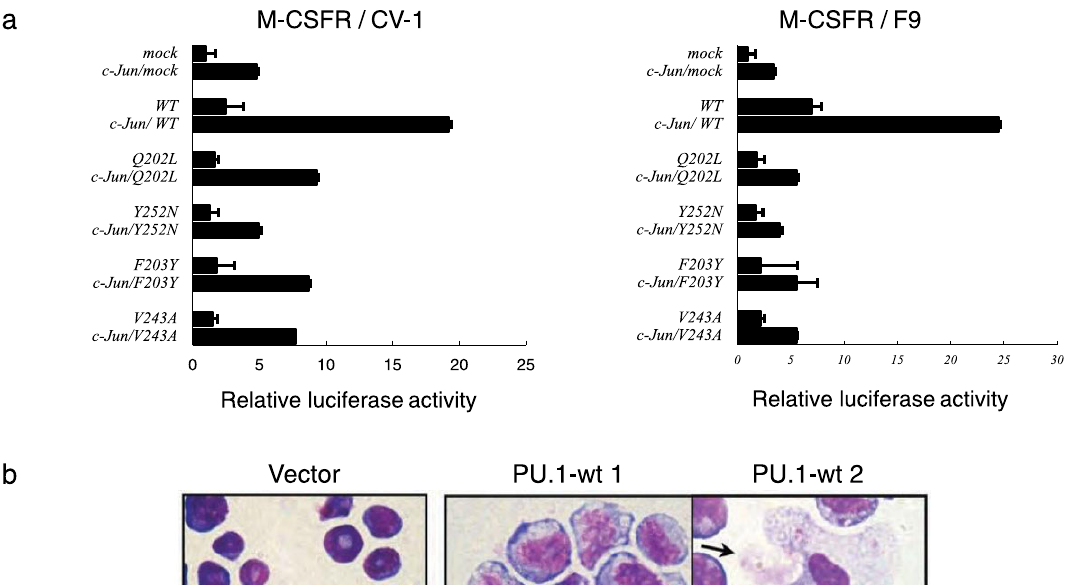
Supplementary Fig. S4, the interactions of mutant PU.1 with C/EBP α , as well as with GATA-2 remain intact, albeit slightly decreased. These results strongly suggest that physical PU.1-c- Jun interaction is crucial for early lympho-myeloid differentia- tion in vivo.